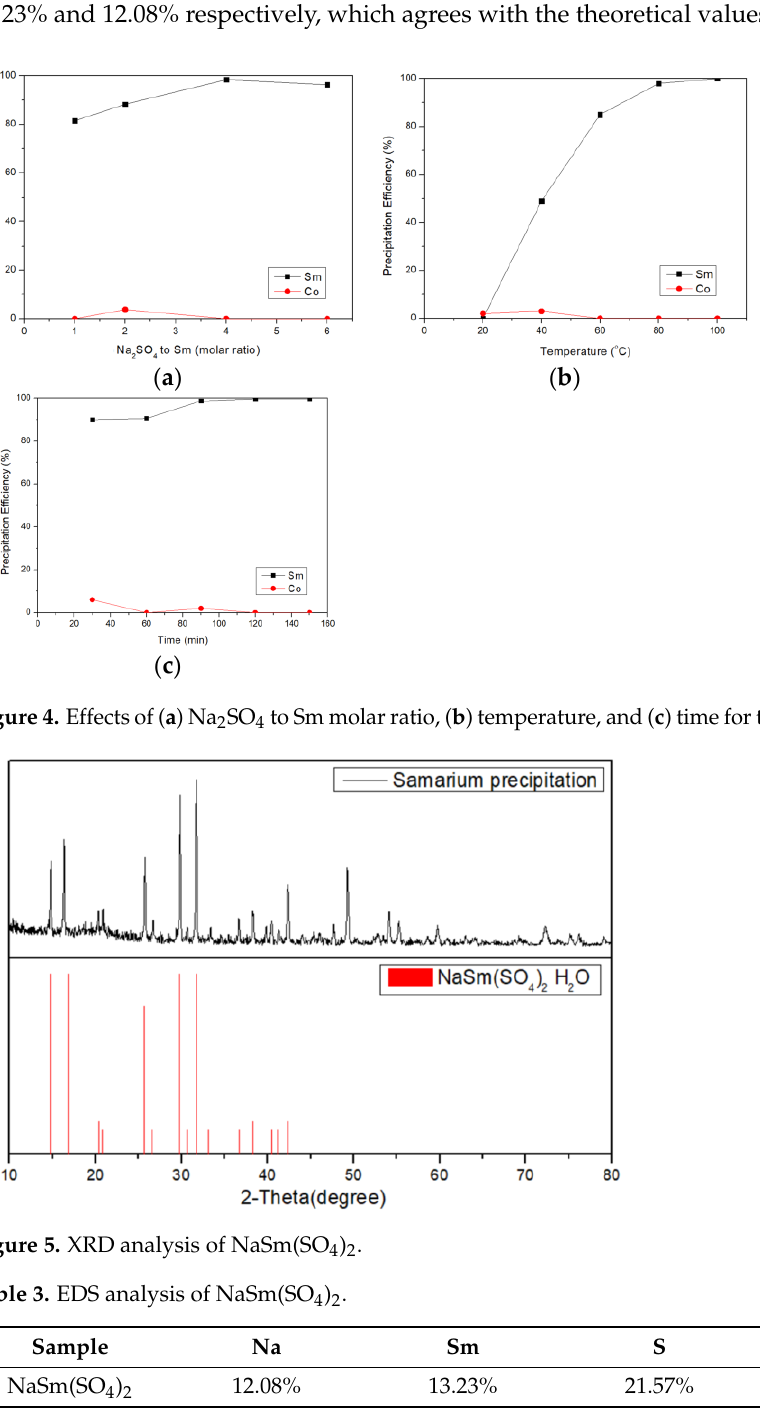
Figure 5. XRD analysis of NaSm(SO 4 ) 2. Table 3. EDS analysis of NaSm(SO 4 ) 2.